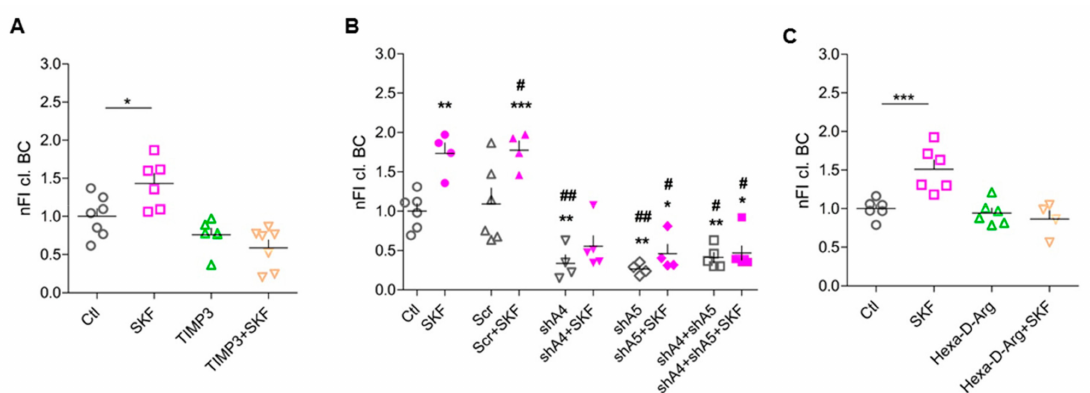
Figure 3. ADAMTS-4 and ADAMTS-5 are essential for D1-like-DA-receptor-induced BC cleavage. ( A ) Inhibition of ADAMTS-4 and ADAMTS-5 with TIMP3 resulted in a decrease in BC cleavage